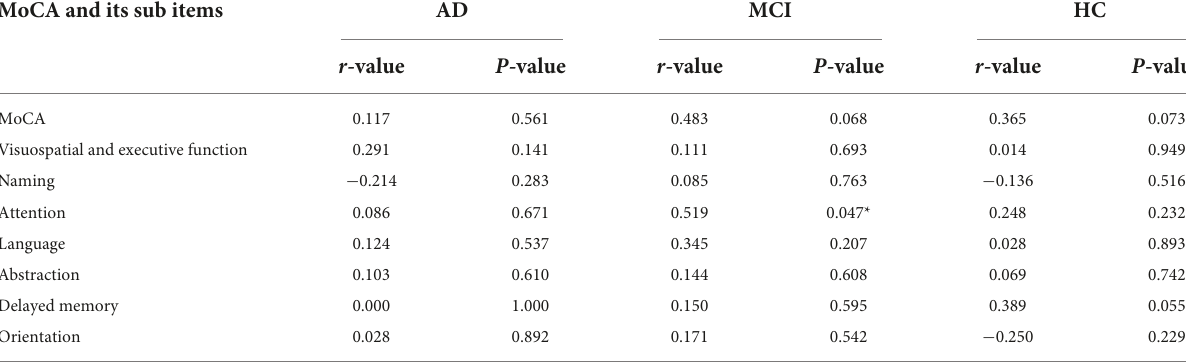
TABLE 4 Correlation analysis between locus coeruleus signal contrast ratios (LC-CRs) and Montreal Cognitive Assessment (MoCA) including its sub items. MoCA and its sub items AD MCI HC r -value P -value r -value P -value r -value P